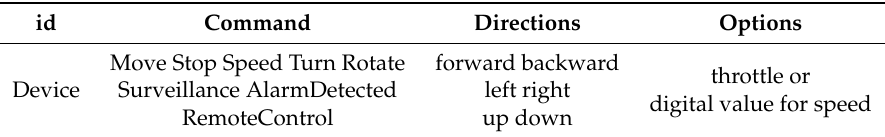
Table 2. Movement commands received from the Arduino controller.